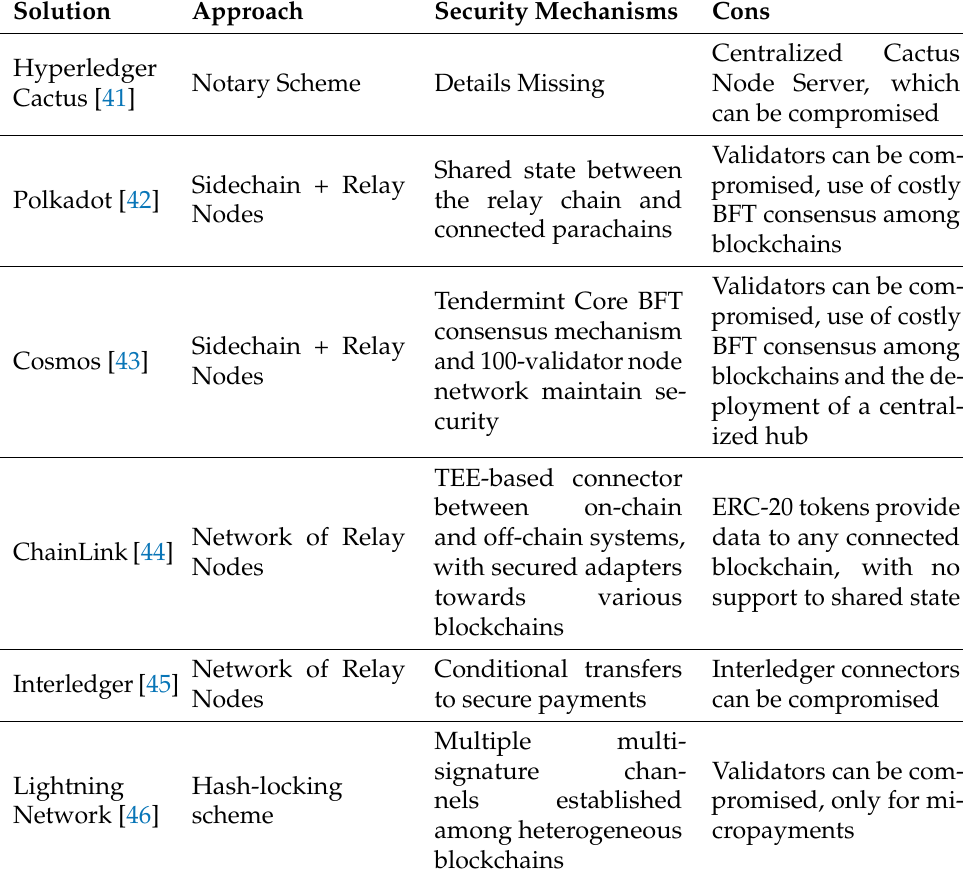
Table 1. Analysis of solutions to have interoperable